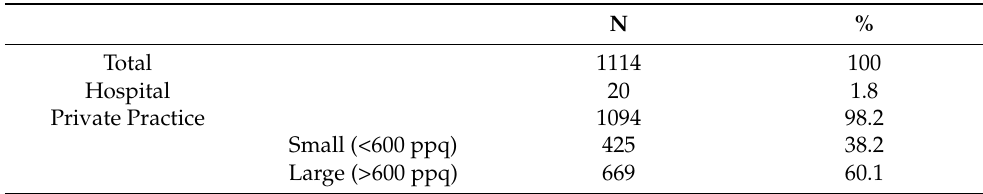
Table 1. Distribution by patients per quarter in private practices.